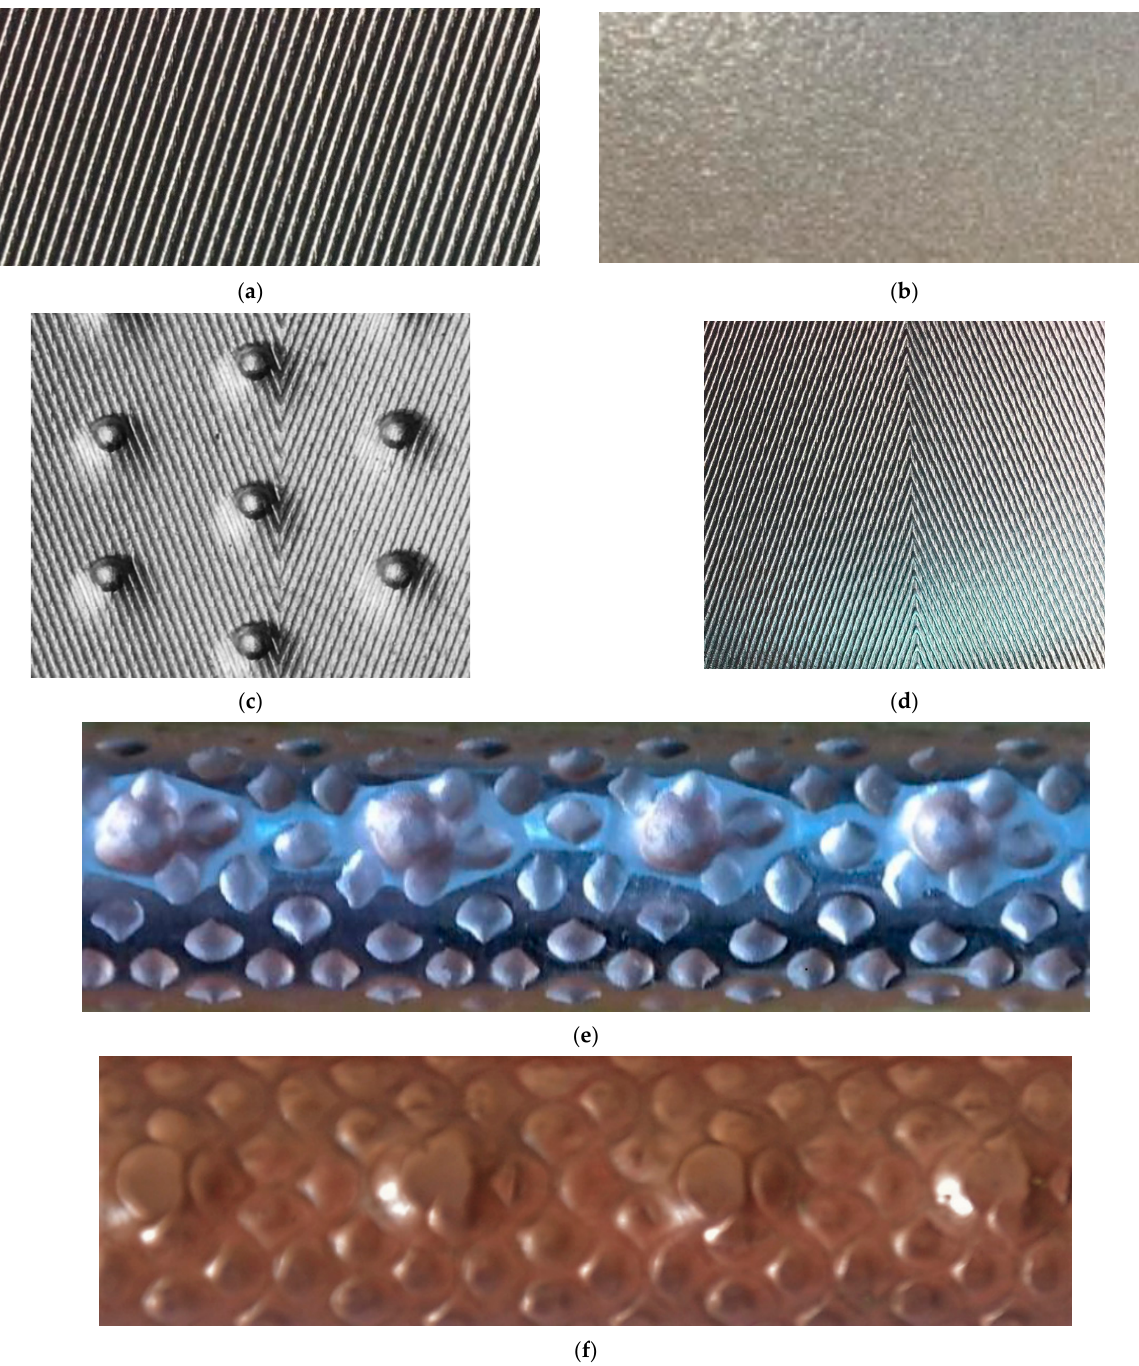
Figure 3. Images of the heat transfer surfaces that were evaluated: ( a ) SS-EHT-HX; ( b ) SS-EHT-HY; Table 2. Accuracy of the primary and calculated parameters.